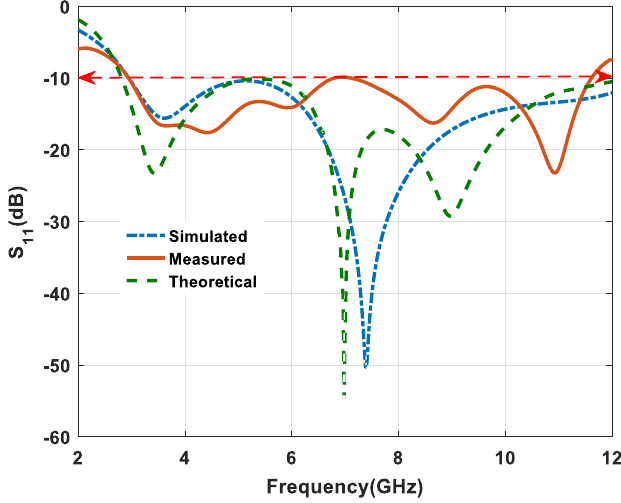
Figure 11. Comparison between S 11 versus frequency plot.